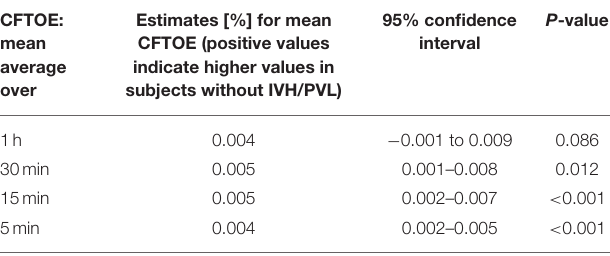
TABLE 5 | ANOVA with a mixed linear model. CFTOE: Estimates [%] for mean mean CFTOE (positive values average indicate higher values in over subjects without IVH/PVL)